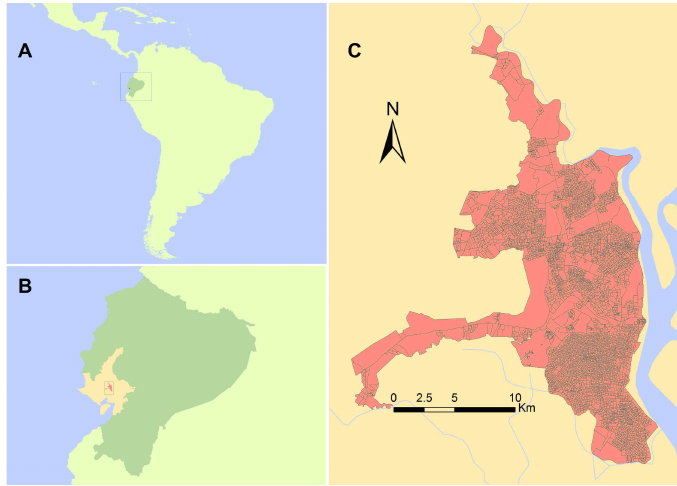
Figure 1. Annual number of reported cases of dengue fever in Guayaquil, Ecuador (2000–2012) ( A ). Cases of dengue fever per census zone in Guayaquil during the 2012 outbreak ( B ).